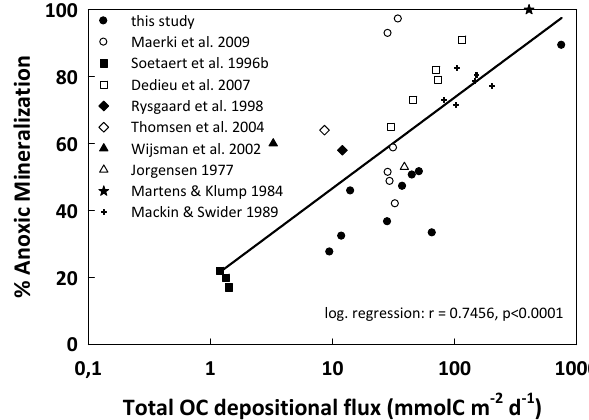
Figure 6 Contribution of anoxic processes in total OC mineralization as a function of total OC Fig. 6. Contribution of anoxic processes in total OC mineraliza- depositional flux for the Rhône River prodelta and its adjacent continental shelf (this study) and a compilation of several data. tion as a function of total OC depositional flux for the Rhˆone River prodelta and its adjacent continental shelf (this study) and a compi- lation of several